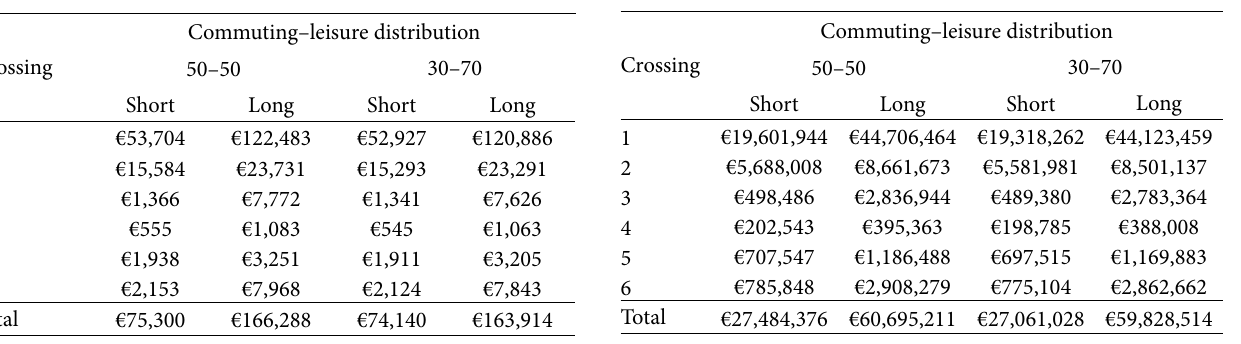
Table 6: Summary of delay costs per day. Table 7: Summary of delay costs per